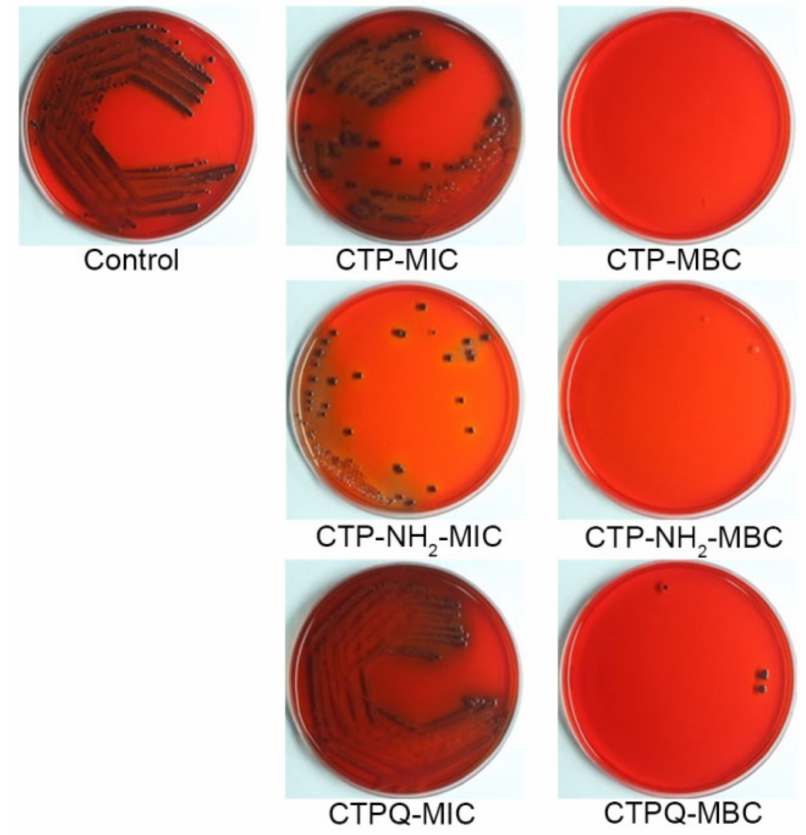
Figure 5. CRA plate of S. aureus ATCC 43300 treated with CTPs (CTP, CTP-NH 2 , and CTPQ) treatment at the MIC (32 µ g/mL) and the MBC (64 µ g/mL) for 9